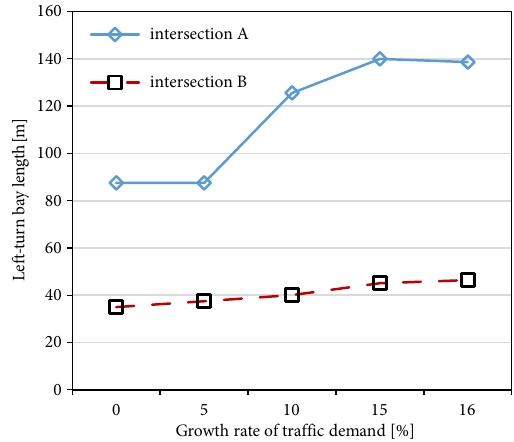
Figure 4. Variation curve of left-turn bay length versus growth rate of traffic